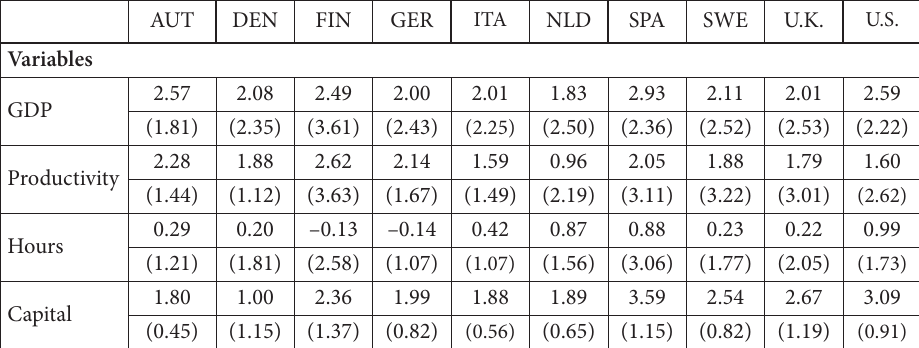
Table 1. Average Annual Growth Rates,